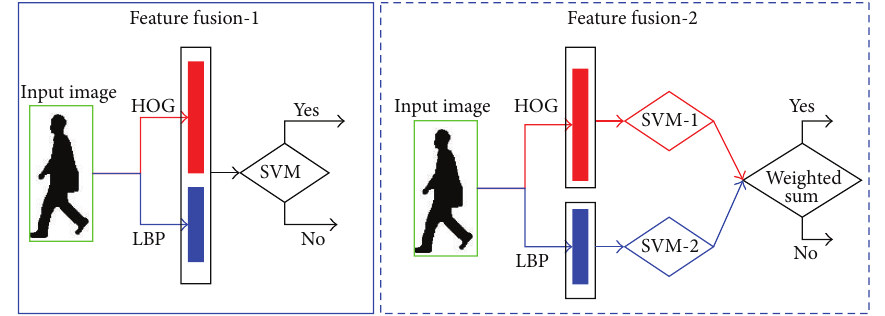
Figure 3: Examples of two feature fusion methods using the SVM as a